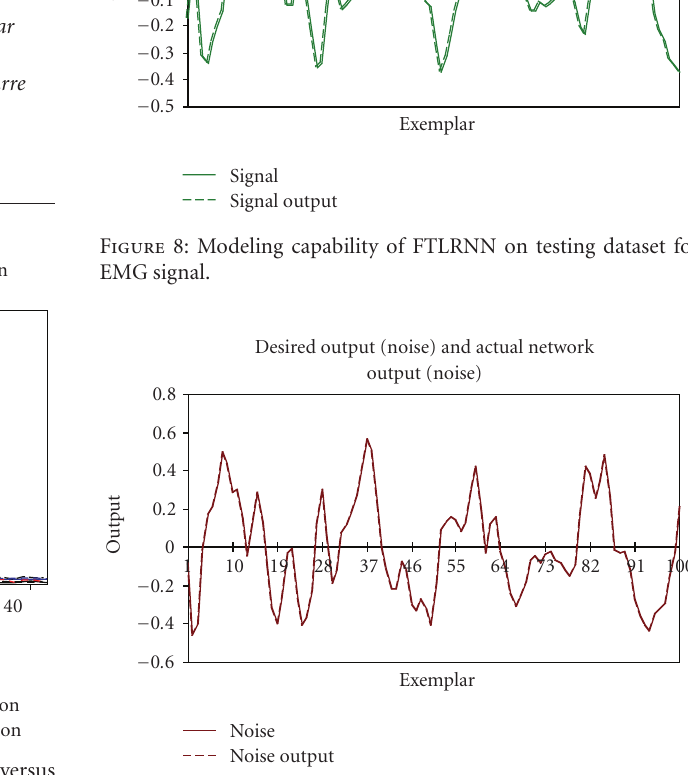
Figure 9: Modeling capability of FTLRNN on testing dataset for EMG noise